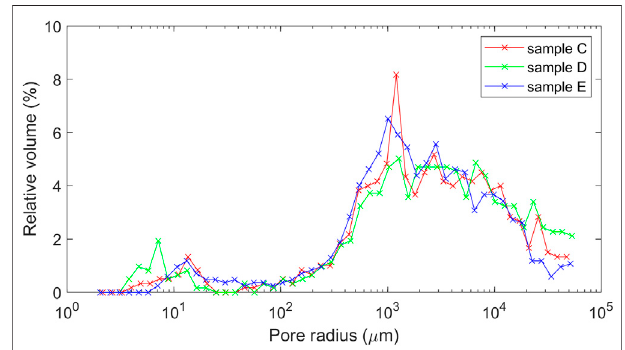
FIGURE 2 | MICP data for the carbonate sample investigated. Here, we show the result obtained from one of the core plugs.